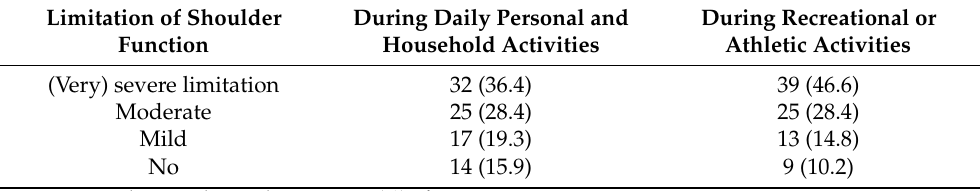
Table 2. Outcome of the Shoulder Rating Questionnaire scores in CNO/SCCH patients.